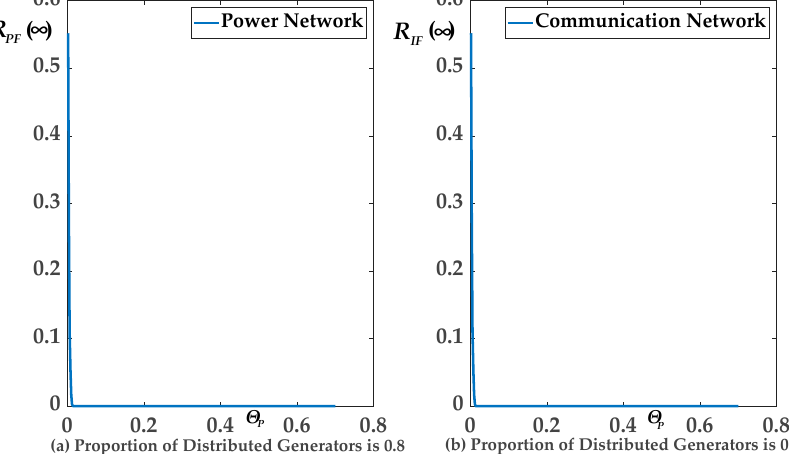
Figure 7. The final expected proportion of normal operational nodes in the PN/communication network (CN) after the CCF stops ( R PF ( ∞ )/ R IF ( ∞ )) of different Θ P in the PN and CN with the ER topological structure.